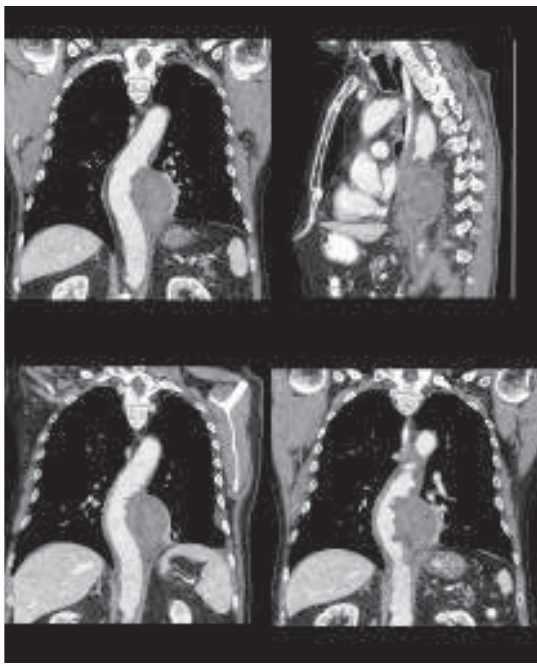
FIGURE 5. Rupture of the thoracic aorta aneurism with hema- toma formed in the place of